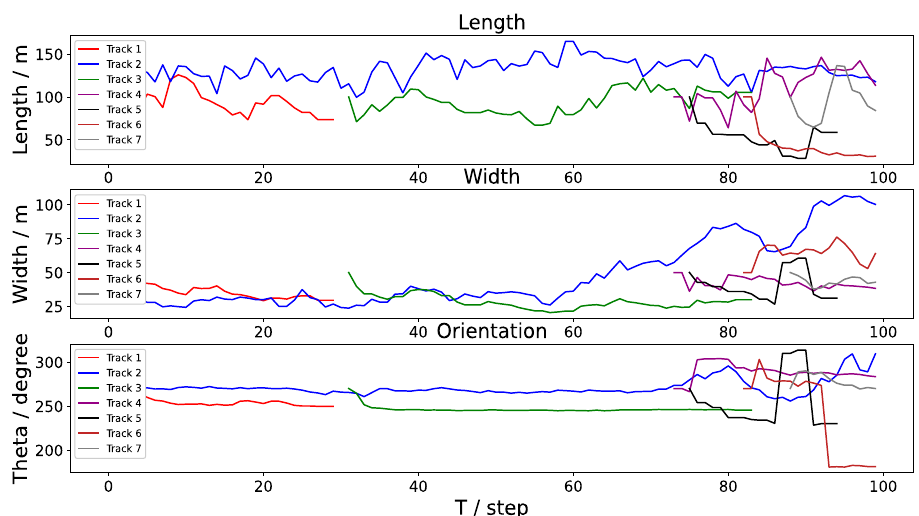
Figure 31. Estimation of the multi-target size and azimuth.